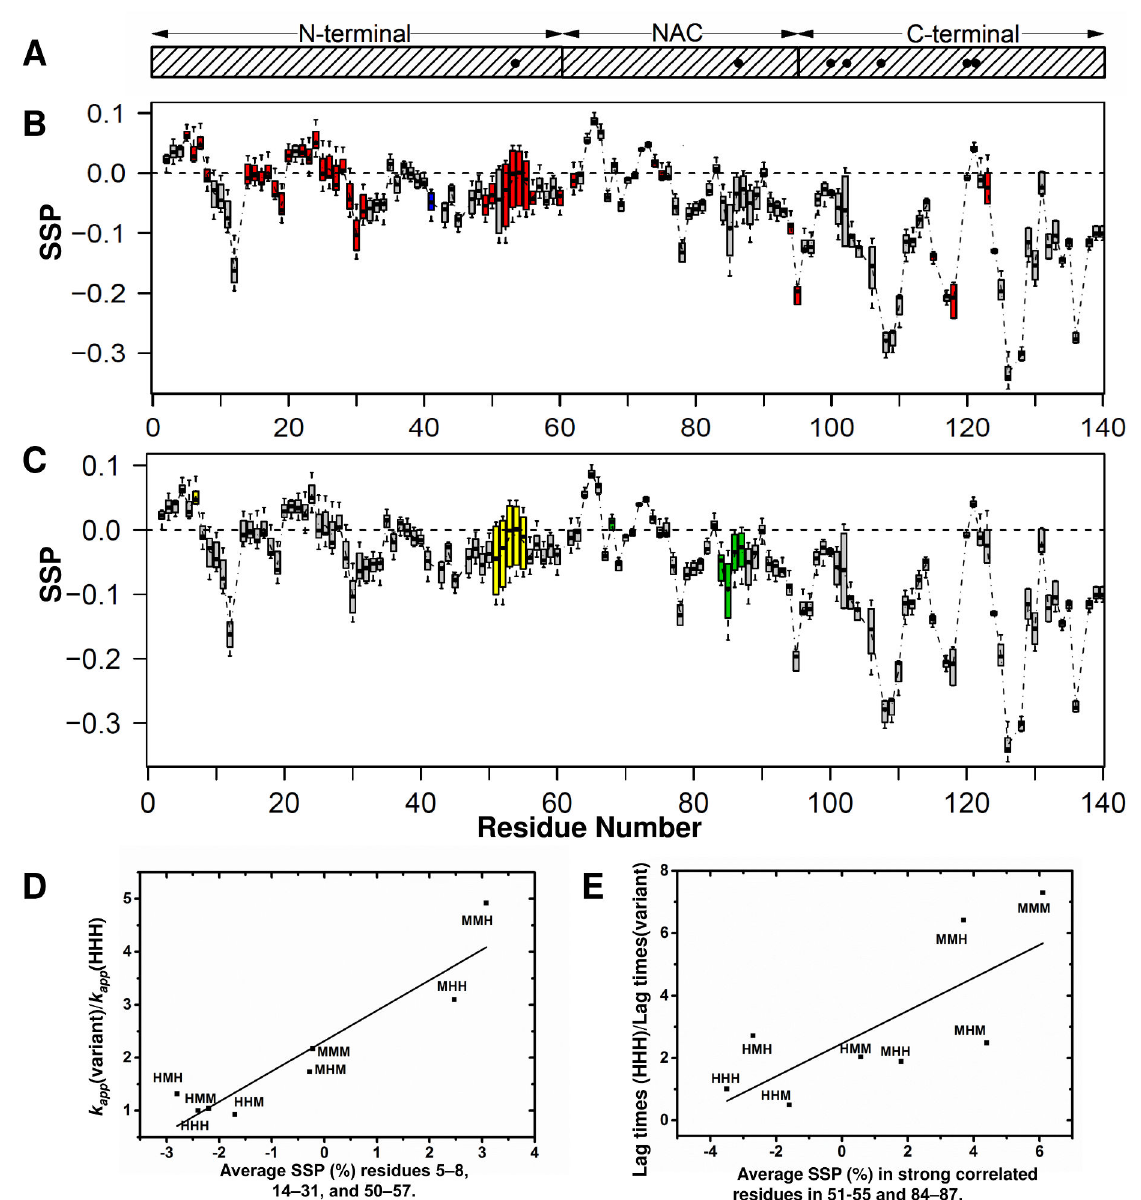
Figure 1. Quantitative correlation of SSP values to fibril kinetics in the non-acetylated human-mouse chimera αSyn set. A. The N-, NAC, and C-terminal regions are shown in the schematic representation of αSyn. The black dots represent seven possible substitutions between human and mouse WT αSyn. B. Boxplot diagram representing the dispersion of SSP values for each human- mouse chimera as a function of residue, where each boxplot is a five-number summary of the SSP distribution of the eight variants. Residues are shaded based on their correlation with the growth rate (k ), data from a previous study [39]. Residues with high app positive correlation are shaded in red (r > 0.7), high negative correlation in blue (r < -0.7) and no correlation are shown as grey (-0.7 < r < 0.7). C. The representation is the same as in Figure 1B, however, the boxplots are shaded based on correlation to lag times. Residues with highest positive correlation are shaded in light red (r > 0.5), with highest negative correlation are shaded in light blue (r < -0.5) and no correlation with grey (-0.5 < r < 0.5). D. Correlation between the average SSP in regions that have a strong correlation with k determined by Figure 1B (residues 5–8, 14–31, and 50–57) and k (variant)/ k (HHH) for all eight variants, of app app app which details of naming and BMRB accession numbers are indicated in Table 1. The correlation coefficient is r = 0.93. The correlation function is Y = (2.32±0.2)+ (0.57±0.9)* X.E. Correlation between the average SSP in regions that have strong correlation with lag times determined by Figure 1C (residues 51–55 and 84–87) and lag times (HHH)/lag times (variant) for all eight variants. The correlation coefficient is r = 0.75. The correlation function is Y = (2.46±0.66) + (0.53±0.19)* X. doi: 10.1371/journal.pone.0075018.g001 PLOS ONE |